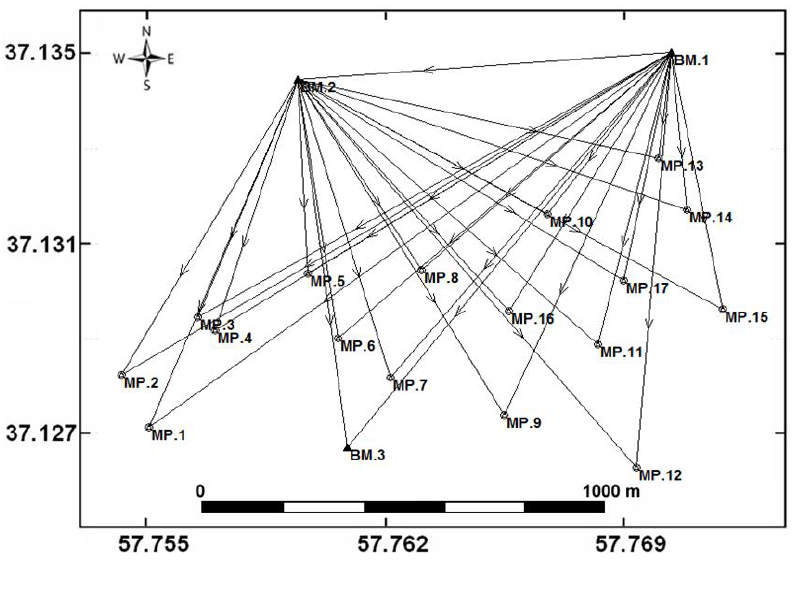
Figure 7. Schematic view of GPS network observations: black lines represent intersectional considering baselines between